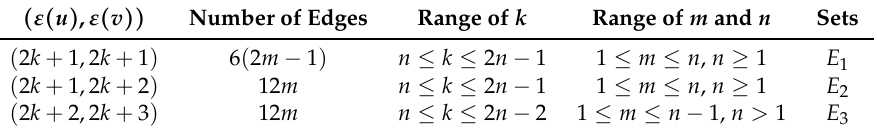
Table 2. Edge partition of oxide network for ( n -levels) based on eccentricity of end vertices. ( ε ( u ) , ε ( v )) Number of Edges Range of k Range of m and n